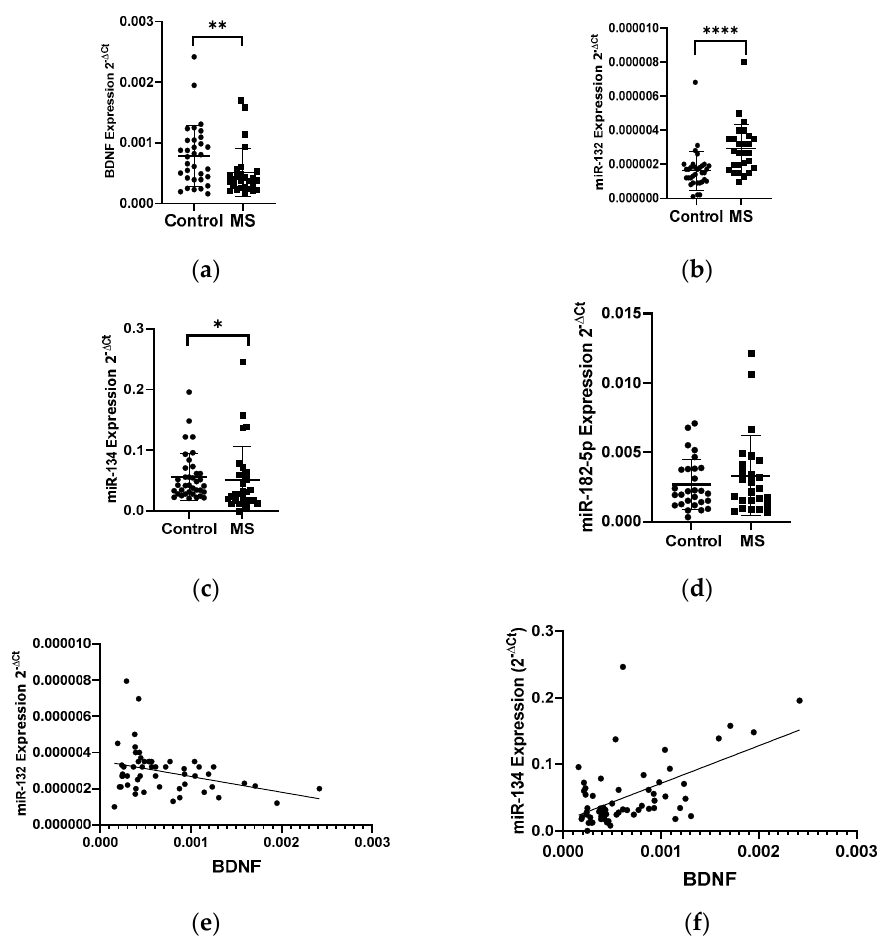
Figure 1. Expression levels and correlations of BDNF, miR-132, and miR-134 in PBMCs from multiple sclerosis patients and healthy controls. Expression levels 2 - Δ Ct are shown for: ( a ) BDNF, ( b ) miR-132, ( c ) miR-134, and ( d ) miR-182-5p. ( e , f ) Spearman correlation (R) plots for the expression levels of BDNF with miR-132 and with miR-134 (combined for all cohorts; N = 61). The PBMCs were from multiple sclerosis patients ( N = 27), aged 59 ± 5.5 years, and healthy controls, aged 60 ± 6 years ( N = 33). Expression levels were determined by real-time PCR (see Methods). Statistical analysis of differences between the groups of data was carried out using the Mann–Whitney U-test. Values of p ≤ 0.05 were regarded as statistically significant ( p * ≤ 0.05, p ** ≤ 0.01, and p **** ≤ 0.0001).